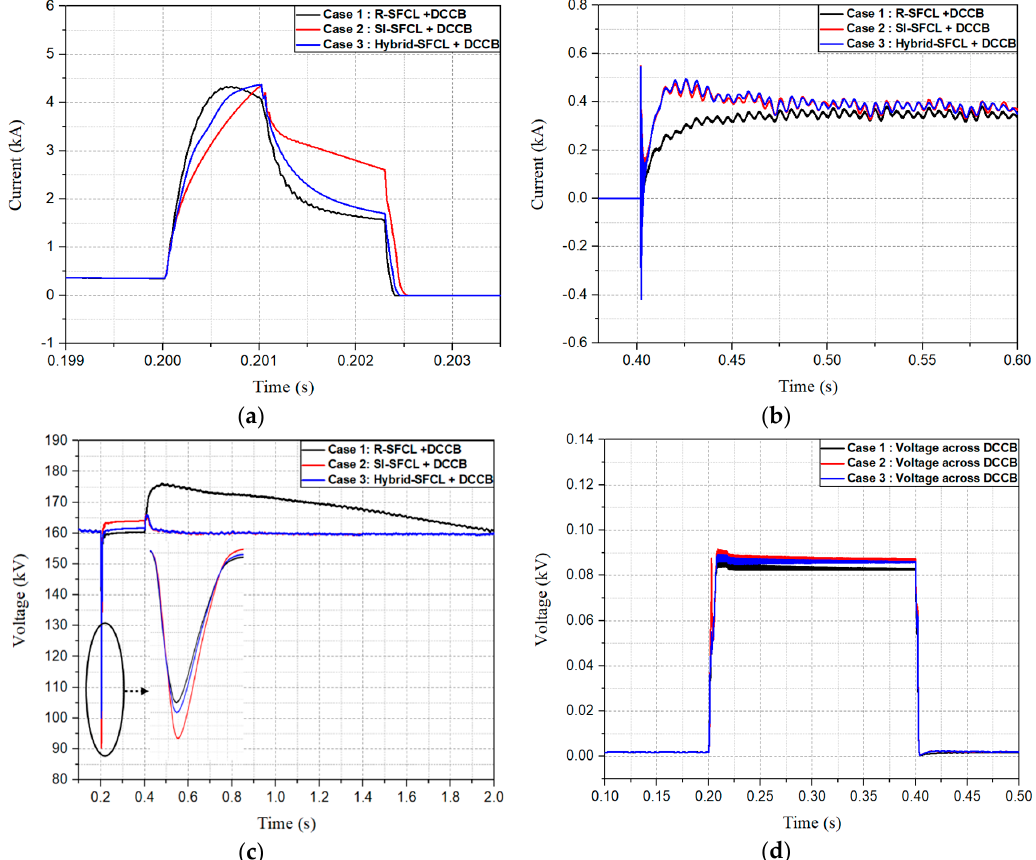
Figure 13. The DC current and voltage waveform in transient state according to protection scheme: ( a ) current waveform in fault period; ( b ) current waveform in recovery period; ( c ) voltage waveform in transient state; ( d ) voltage waveform across DCCB.